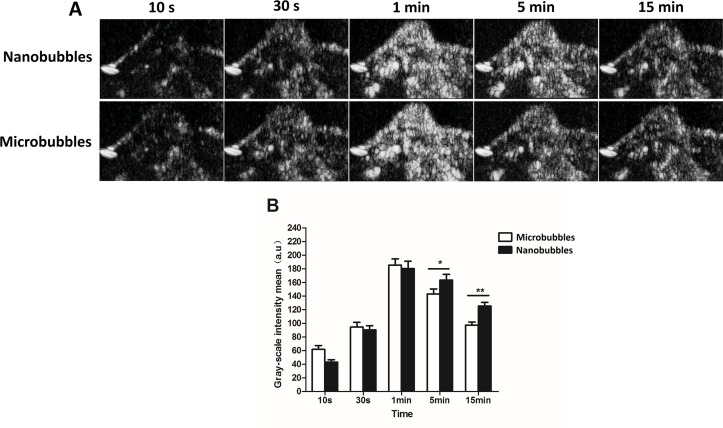
Passive targeting ultrasound imaging of nanobubbles in tumors. (A) Representative ultrasound images of nanobubbles and microbubbles. (B) The quantitative comparison of imaging capability between nanobubbles and microbubbles at different time points.